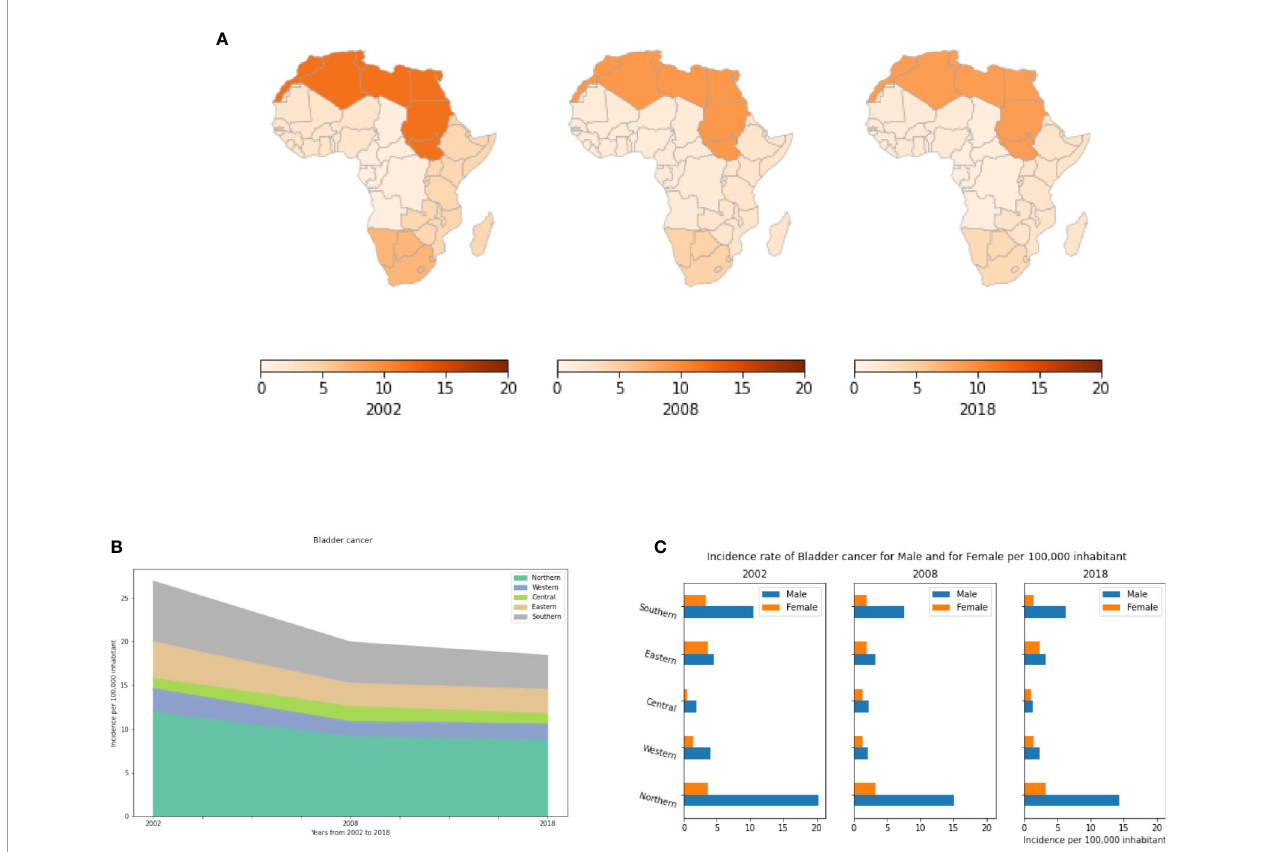
FIGURE 9 | Bladder cancer incidence rates per year, by African region and by gender. (A) Bladder cancer incidence per 100,000 inhabitant in all Africa regions. (B) Dynamics of incidence rates from 2002 to 2018. (C) Bladder cancer incidence by